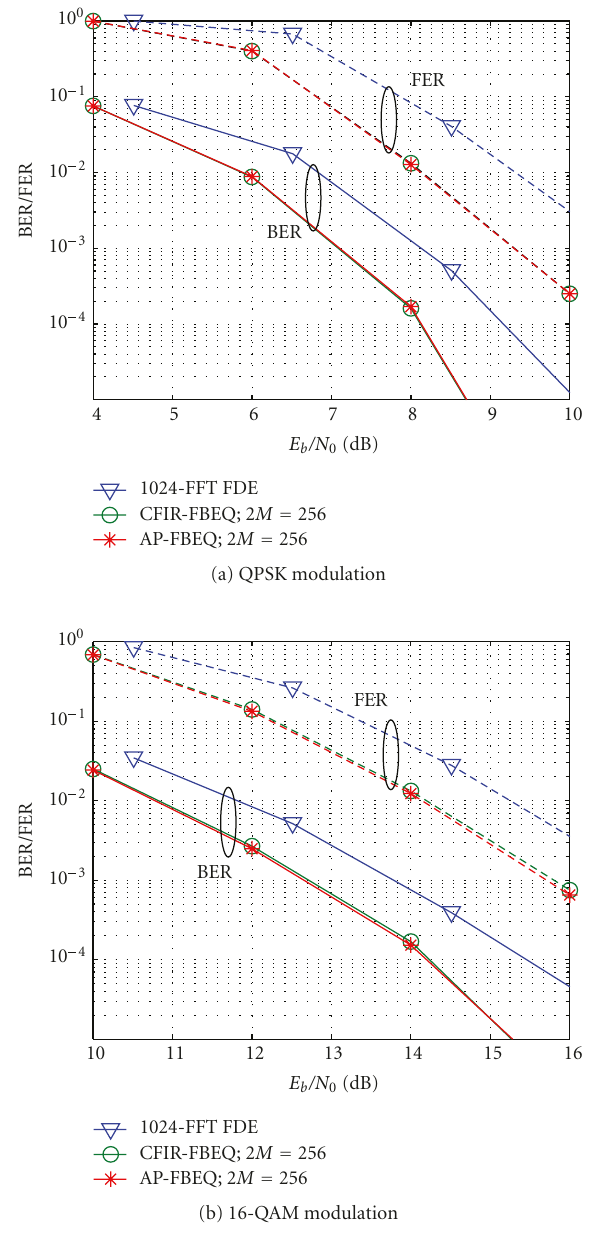
Figure 11: Coded BER and FER performance comparison between FFT-FSE and FB-FSE with practical system parameters and LDPC coding. Both 3-tap CFIR and AP Case 3 subband equalizers are in- cluded in FB-FSE models.